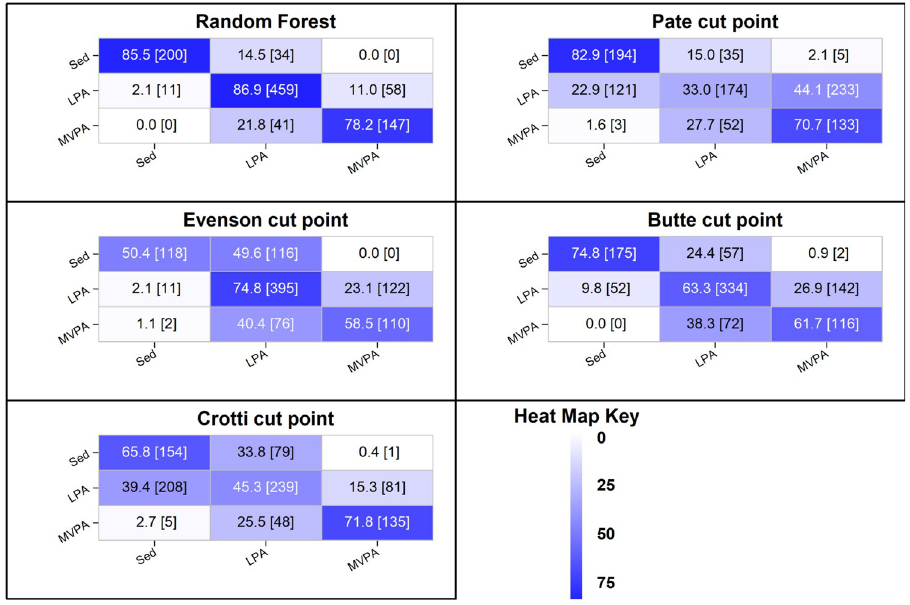
Fig 2. Heat map confusion matrix for the hip placement random forest physical activity classification model and cut-points. Diagonal = correct predictions; Columns = predictions; Rows = ground-truth.